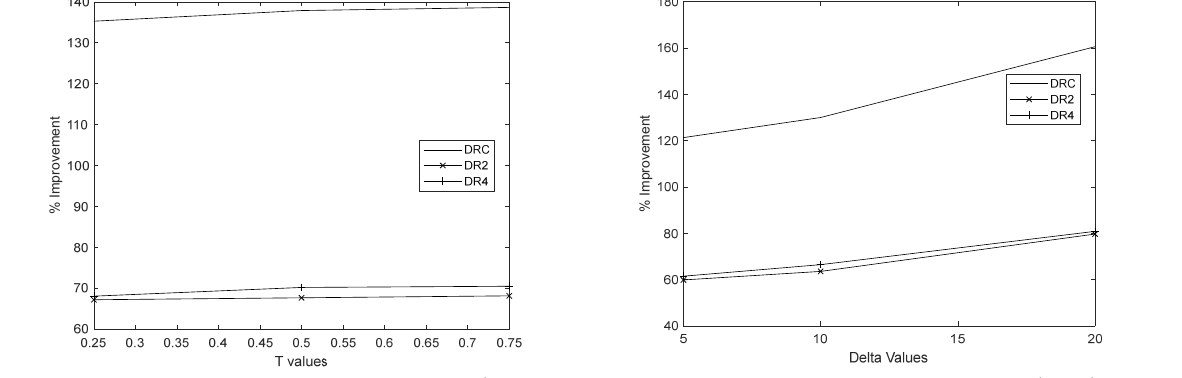
Fig. 4. Percentage Improvement versus T values Fig. 5. Percentage Improvement versus Delta